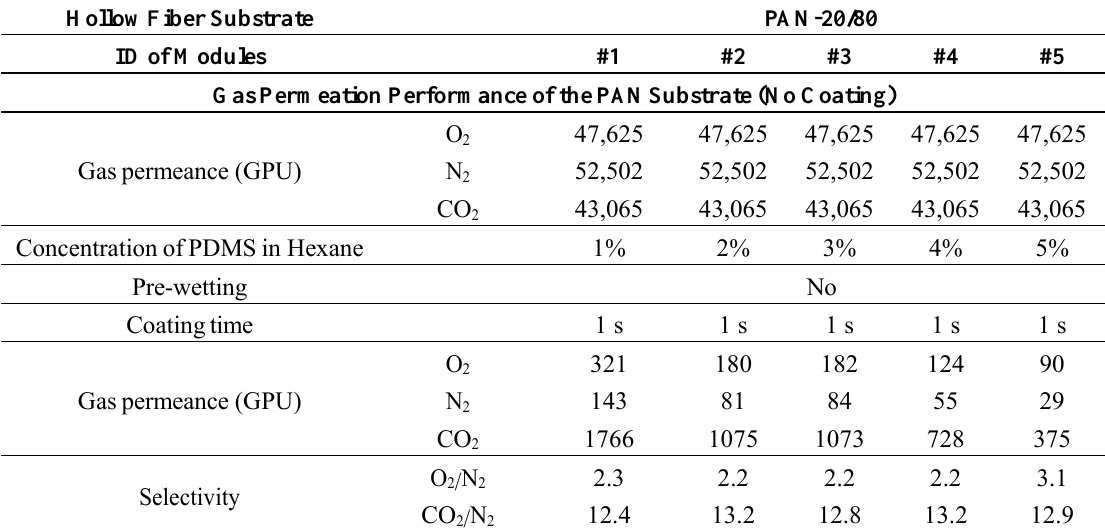
Table 2. Coating conditions and pure gas permeation performance of PAN/PDMS fibers. Hollow Fiber Substrate